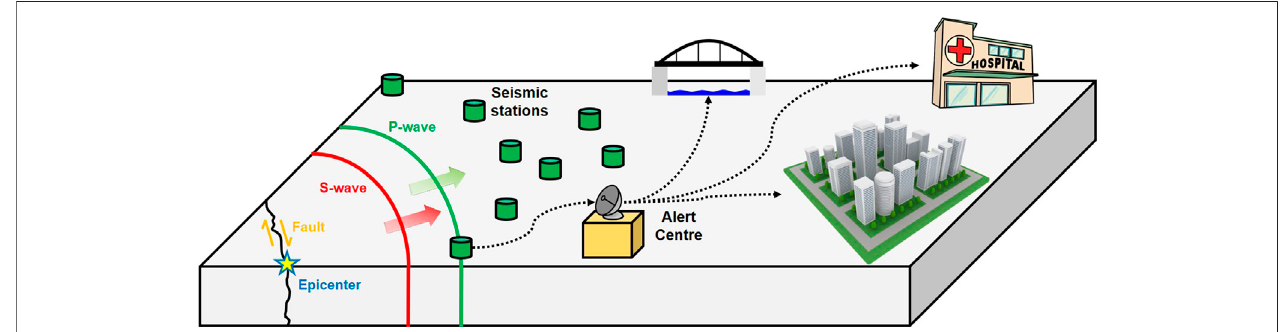
FIGURE 1 | The technical principles of an earthquake early warning